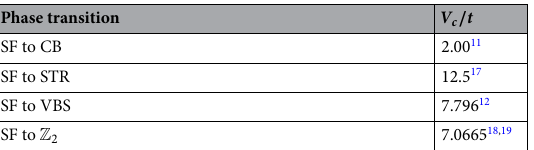
Table 1. Critical values V c / t for the considered phases. For uncertainties and further details we remand to the references. Notice that the V c / t from 17 refers to simulations with no cutoff in the range of the interaction. Here, we put a cutoff to four lattice spaces, so the exact position of the transition will be slightly